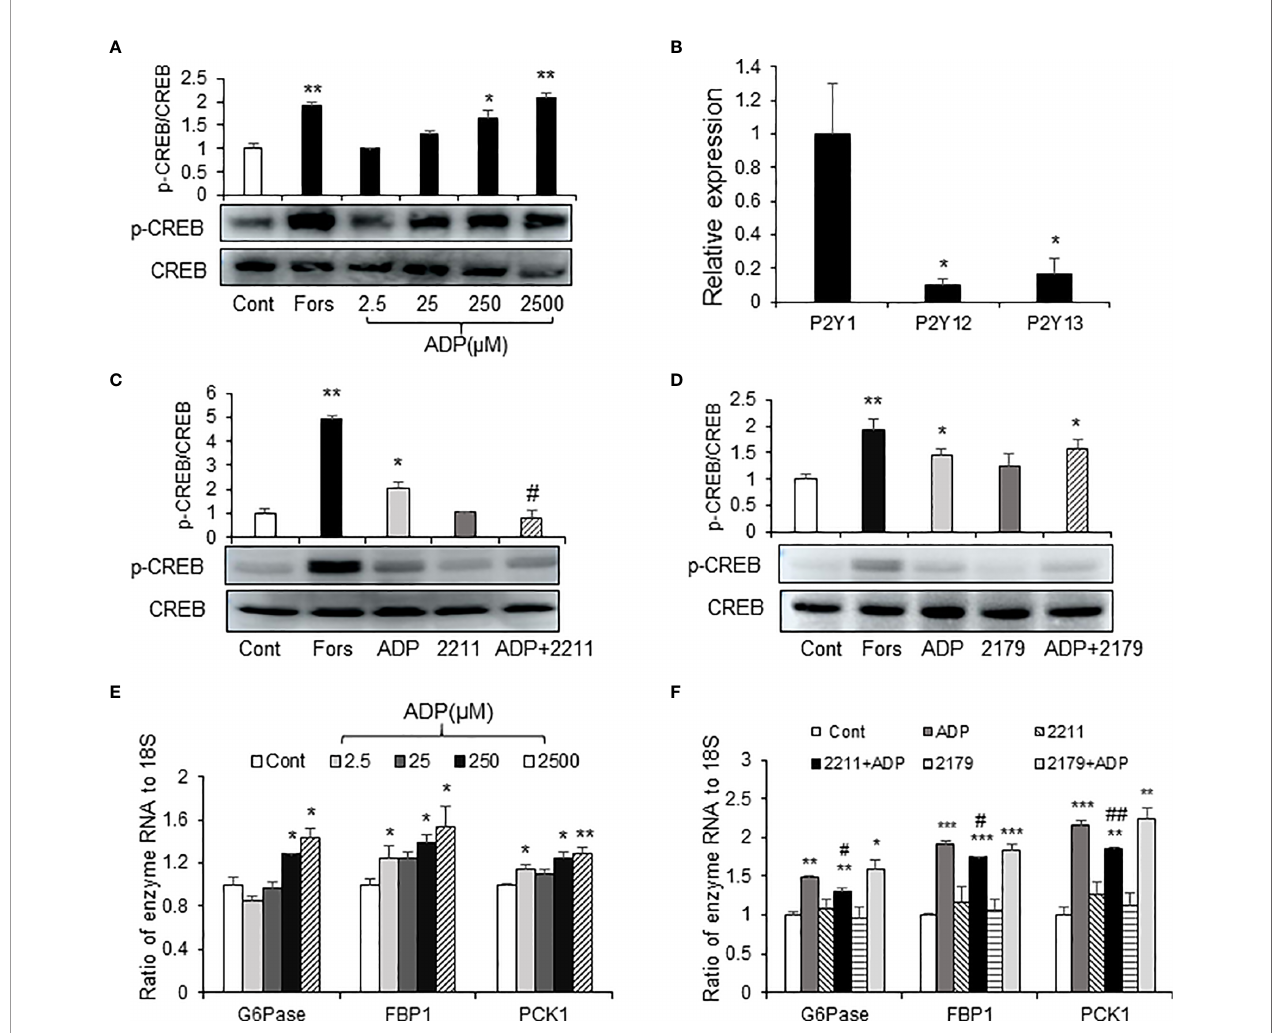
FIGURE 4 | ADP activated the cAMP/PKA/CREB pathway through the P2Y13 receptor in primary hepatocytes. (A) Induction of CREB phosphorylation by ADP. The p-CREB and CREB signals were determined in the primary hepatocyte after ADP (2.5, 25, 250, 2500 m M) treatment. Forskolin (50 m M) was used as a positive control. The primary hepatocytes were incubated with 2.5 mM ADP for 1h. (B) Relative expression of ADP receptors of P2Y1, P2Y12 and P2Y13 in the mouse liver (n=3). *p < 0.05 vs. the P2Y1 relative expression. (C) Blockage of P2Y13. The receptor was blocked with the chemical antagonist MRS2211 (50 m M). (D) Blockage of P2Y1. The receptor was blocked with the chemical antagonist MRS2179 (50 m M). The antagonists were added 30min before ADP treatment. The experiments were repeated at least three times with consistent results. Representative blots are presented. (E) Induction of gluconeogenic genes by ADP. The mRNA levels of gluconeogenic genes ( G6pase , Fbp1 , Pck1 ) were determined with qRT-PCR after ADP (2.5, 25, 250, 2500 m M) treatment for 1h. (F) The effects of MRS2211(50 m M) and MRS2179 (50 m M) on the mRNA expression was determined. The data in bar fi gure represents mean ± SEM. *p < 0.05; **p < 0.01; ***p < 0.001 vs. the control group; # p < 0.01; ## p < 0.01 vs. the ADP-stimulated